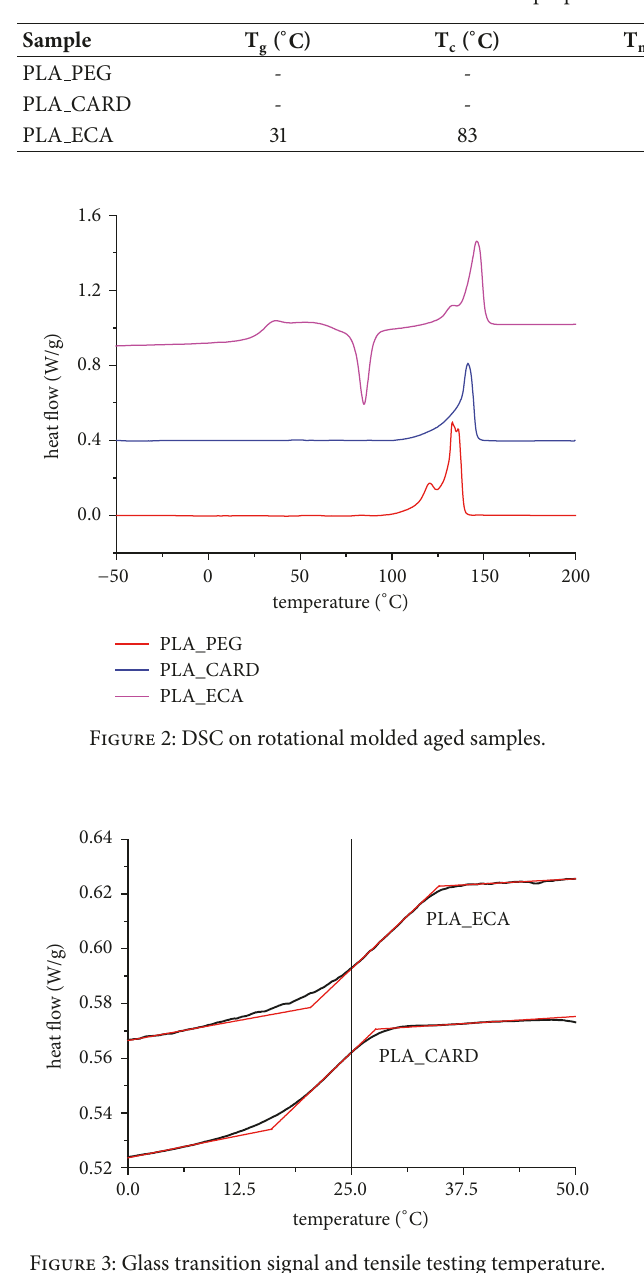
Figure 3: Glass transition signal and tensile testing